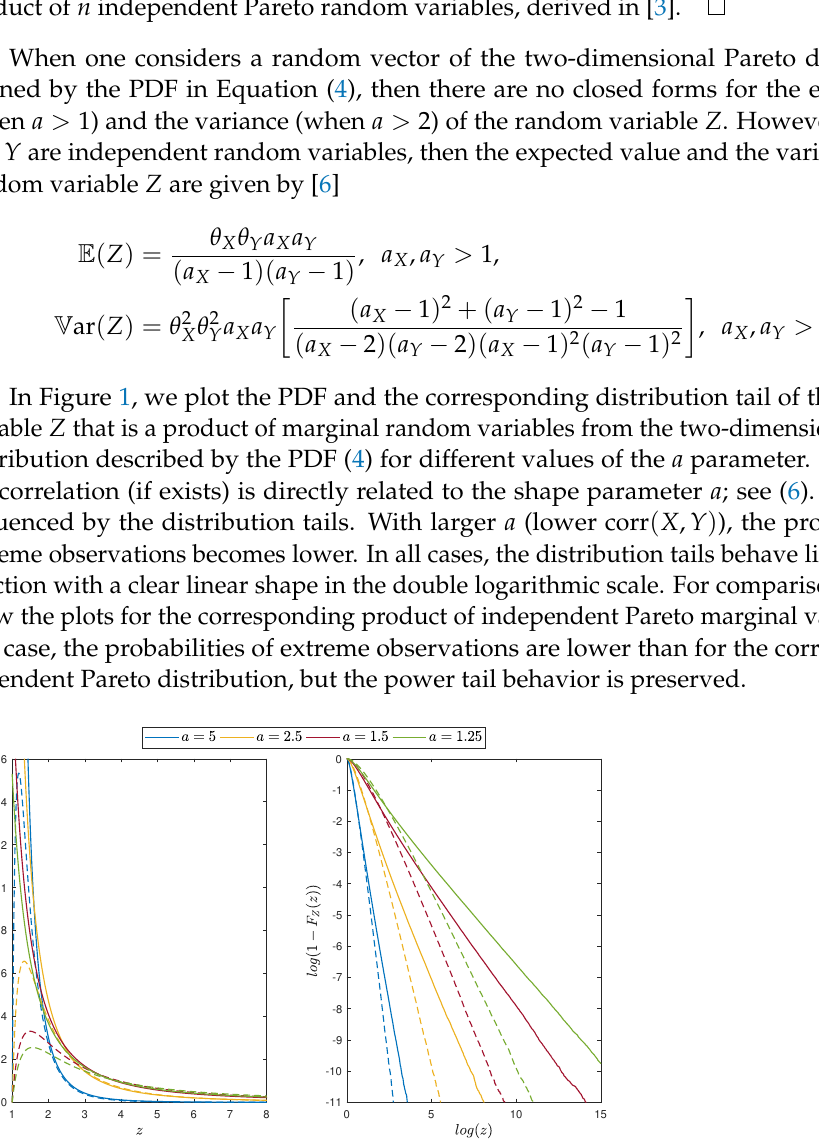
Figure 1. Distribution of the product of marginal random variables from the two-dimensional Pareto distribution with θ X = θ Y = 1 and different values of the a parameter. ( Left panel ): the PDF of the random variable Z . ( Right panel ): the distribution tail for the random variable Z (in log-log scale). The dotted lines correspond to the case when X and Y are independent and a X = a Y = a , θ X = θ Y = 1. The colors of the solid and dotted lines correspond to the same a